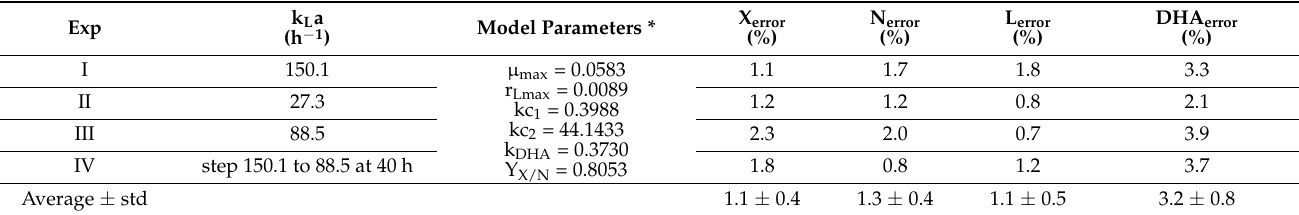
Table 1. Soft sensor parameters and the error between experimental and model results regarding the concentration of the active lipid-free biomass X error , glutamate N error , lipids L error , and DHA error . Units: µ max h − 1 , r’ Lmax (mmol L/g X · h), kc 1 (mmol O 2 /g X), kc 2 (mmol O 2 /g X), k DHA (-), Y X/N (g X/g